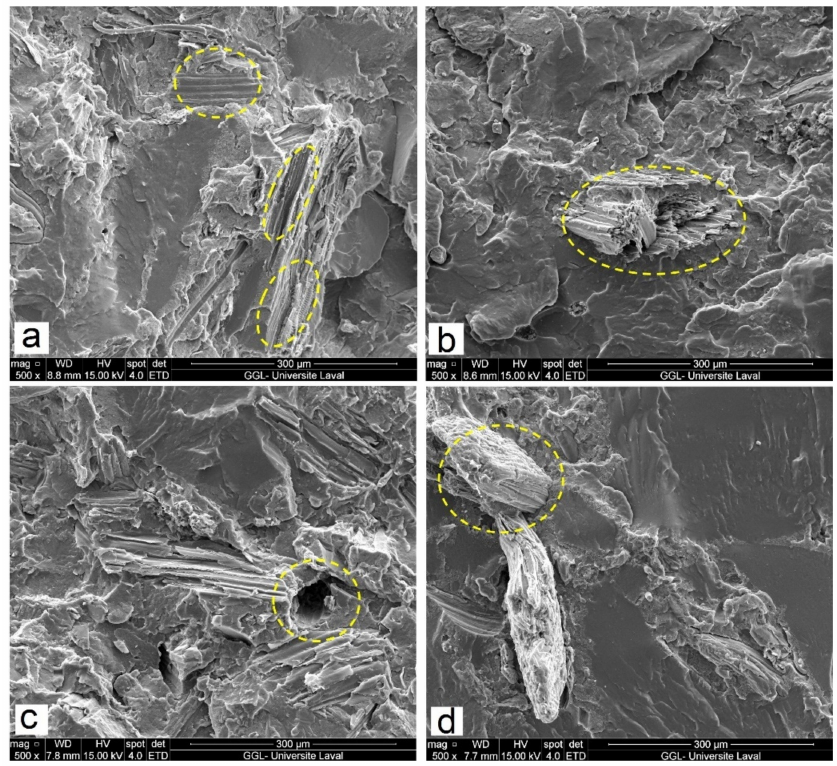
Figure 3. SEM micrographs of ( a ) R25F, ( b ) R25F*, ( c ) R40F and ( d ) R40F* (see Table 1 for